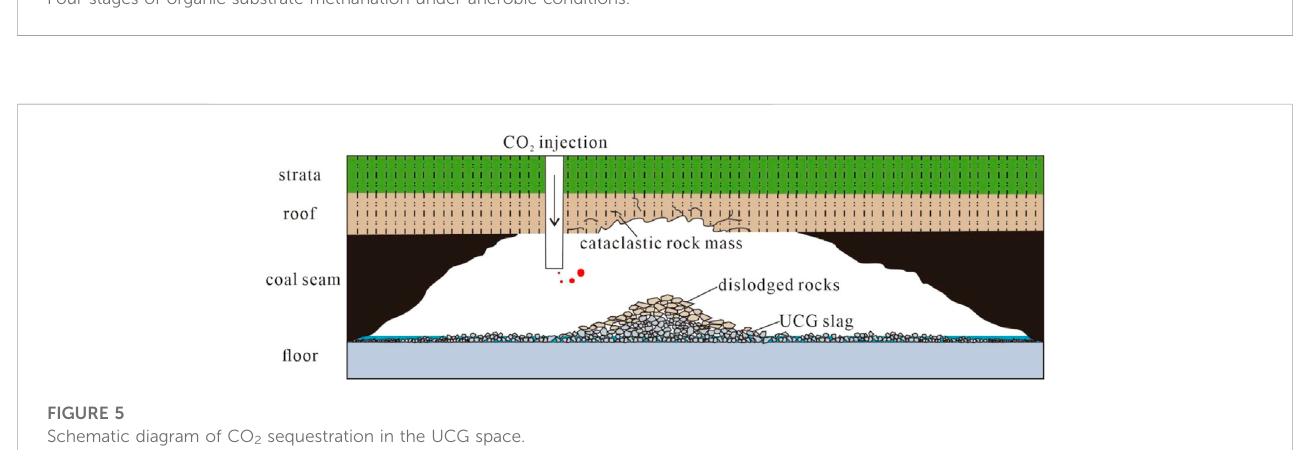
FIGURE 4 Four stages of organic substrate methanation under anerobic conditions.